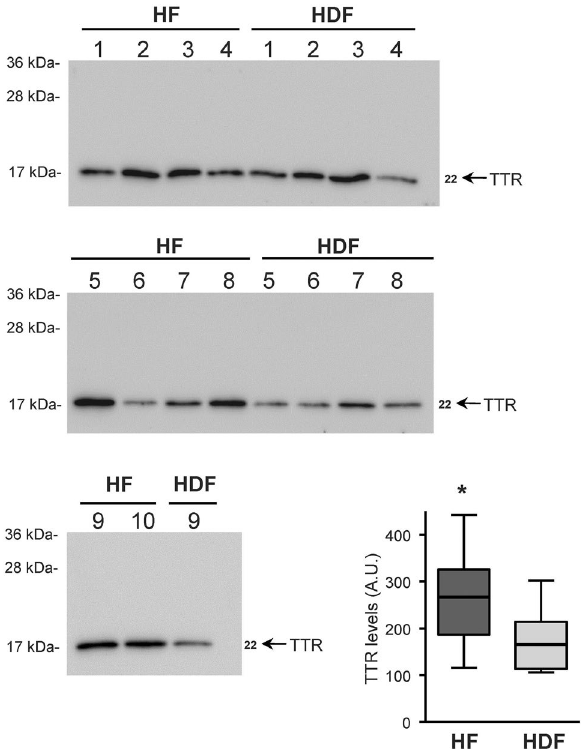
Figure 5. Transthyretin (TTR) detection by western blot in HF and HDF plasma samples. Individual albumin- and IgG-depleted plasma samples of each HF and HDF patient were analysed independently by western blotting with anti-TTR antibody (images). In the images, arrows show the TTR protein detected, and the numbers on the left indicate the apparent molecular mass from standards. The box graph show the quantification of the TTR levels (arbitrary units, A.U.) detected in HF and HDF samples represented as the mean of the 10 and 9 samples, respectively, (thick line) ± 25% and 75% percentile (box) and the minimum and maximum TTR level (whiskers). * p < 0.05, HF compared with HDF by t-test. Images show whole blots. Blotted proteins were staining with Fast Green as loading control of the analyzed samples, and used for normalization of detected TTR levels (see Figure S5 in the Supplementary